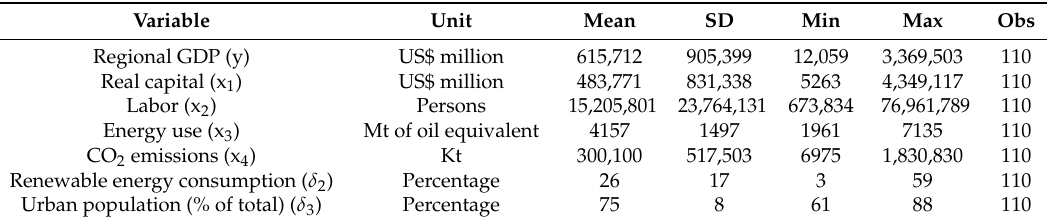
Table 1. Descriptive statistics of all